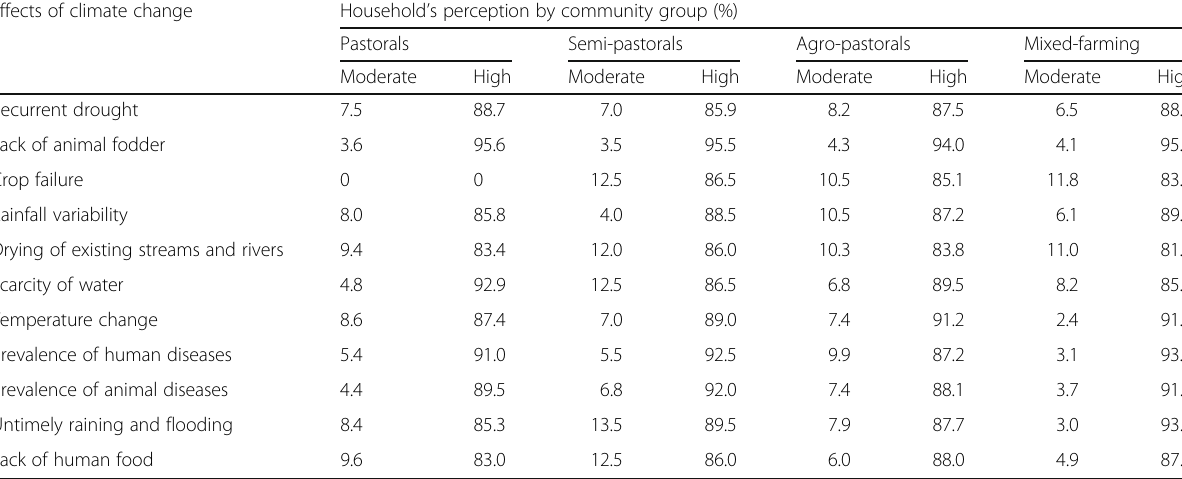
Table 2 Perception of household heads on effects of climatic change Effects of climate change Household ’ s perception by community group